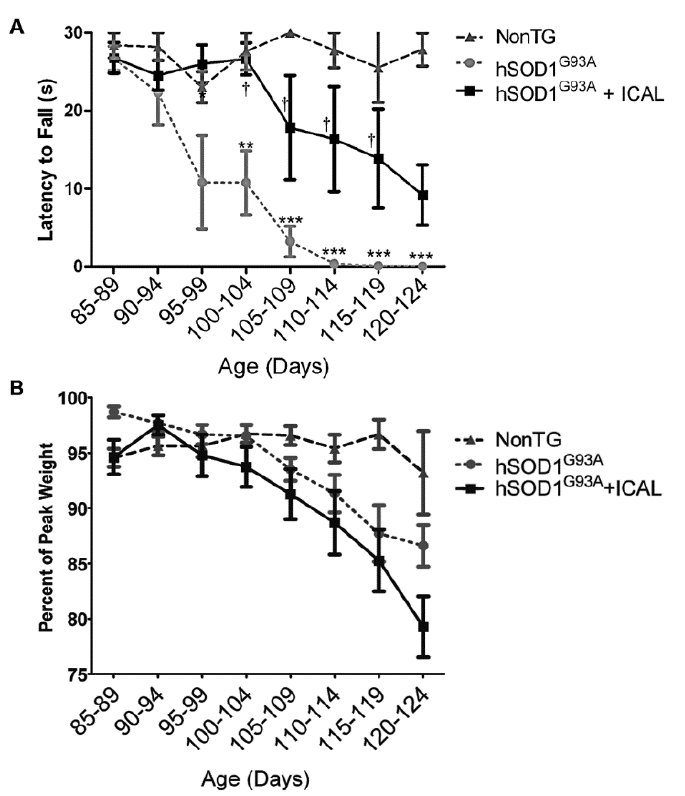
Figure 2. Immunocal ® diminishes the rate of decline in grip strength in hSOD1 G93A mice. ( A ) The paw grip endurance (PaGE) hanging wire test expressed as latency to fall at indicated ages ( n = 13); ( B ) body weight of wild-type and hSOD1 G93A mice expressed as the percent of peak body weight. All data are represented as the mean ± SEM. *** indicates p < 0.001 compared to non-transgenic (NonTG) mice; ** indicates p < 0.01 compared